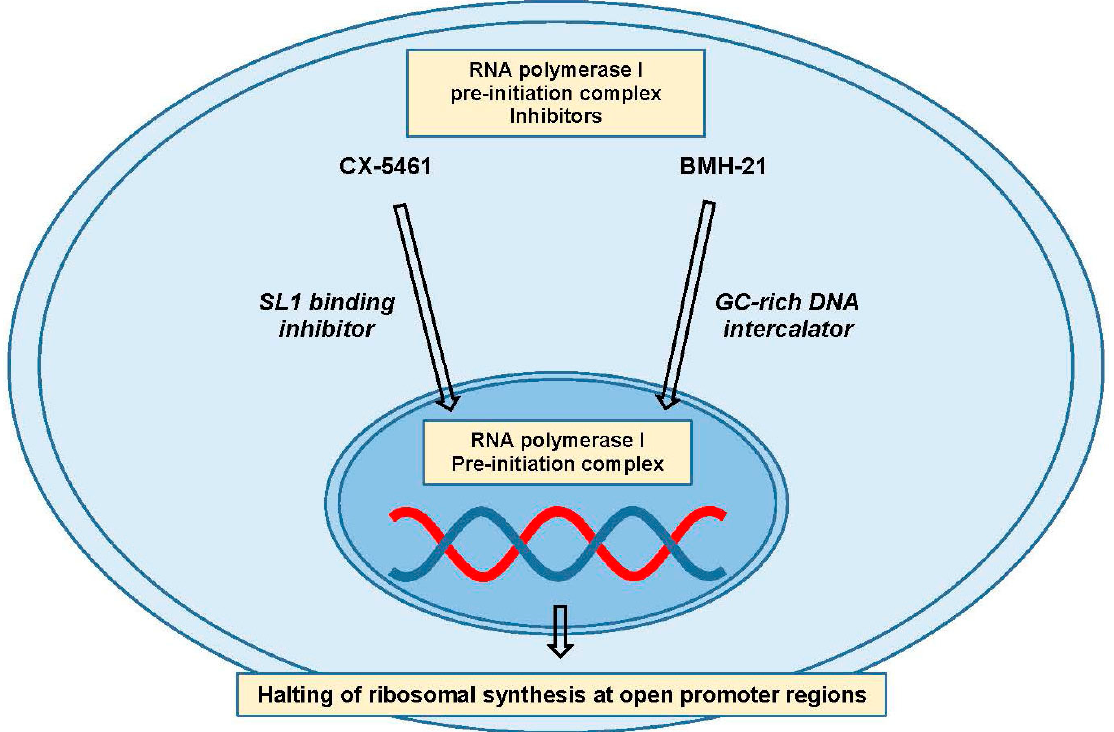
Figure 5. Ribosomal biogenesis targeting. Inhibitors of the RNA polymerase I pre-initiation complex, such as CX-5461 and BMH-21, can inhibit ribosome production and availability. Some data suggests that cancer cells may be more susceptible to targeting this pathway than nontransformed cells. Abbreviations: selective factor 1 (SL1).